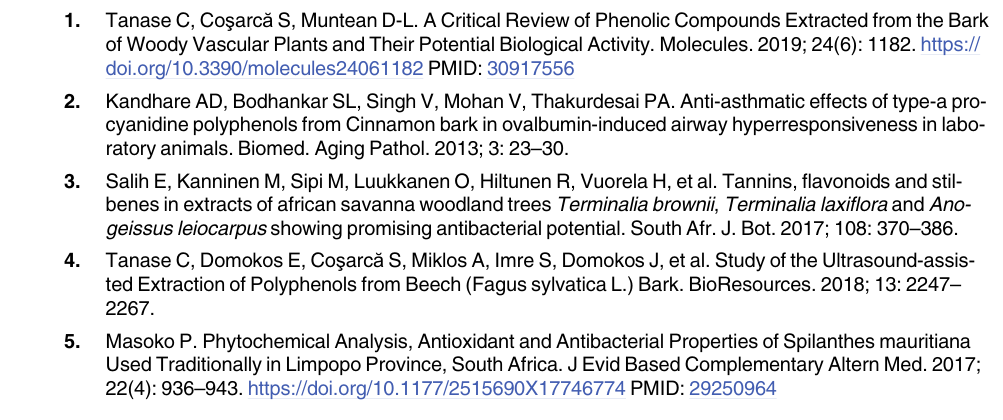
S6 Fig. EIMS of glabranin (6). S7 Fig. EIMS of umbelliferone (7). S8 Fig. EIMS of scopoletin